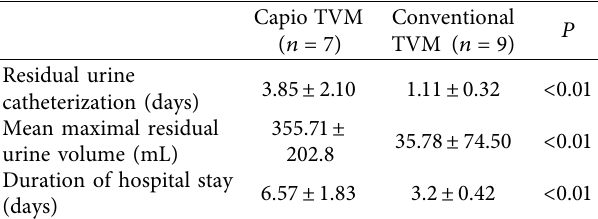
Table 3: Postoperative course.